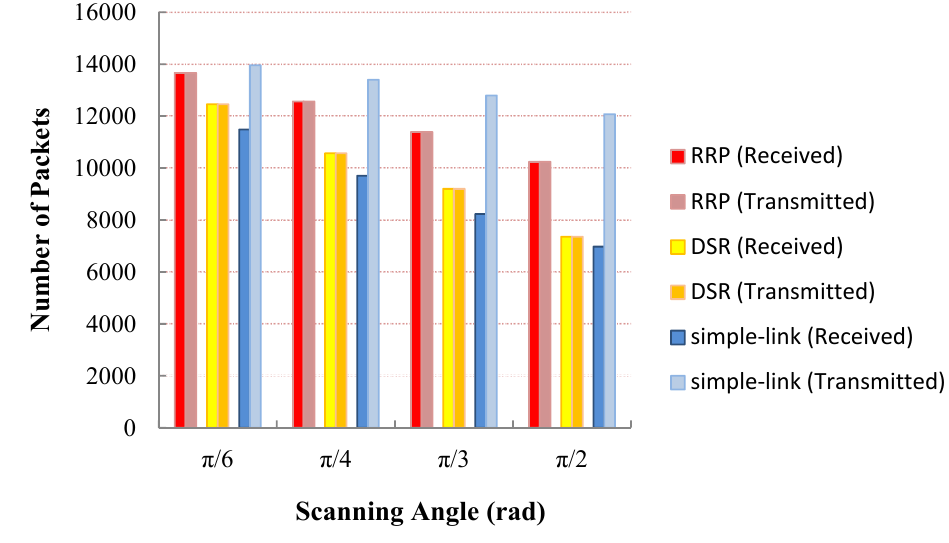
Figure 14. Number of delivered packets vs.